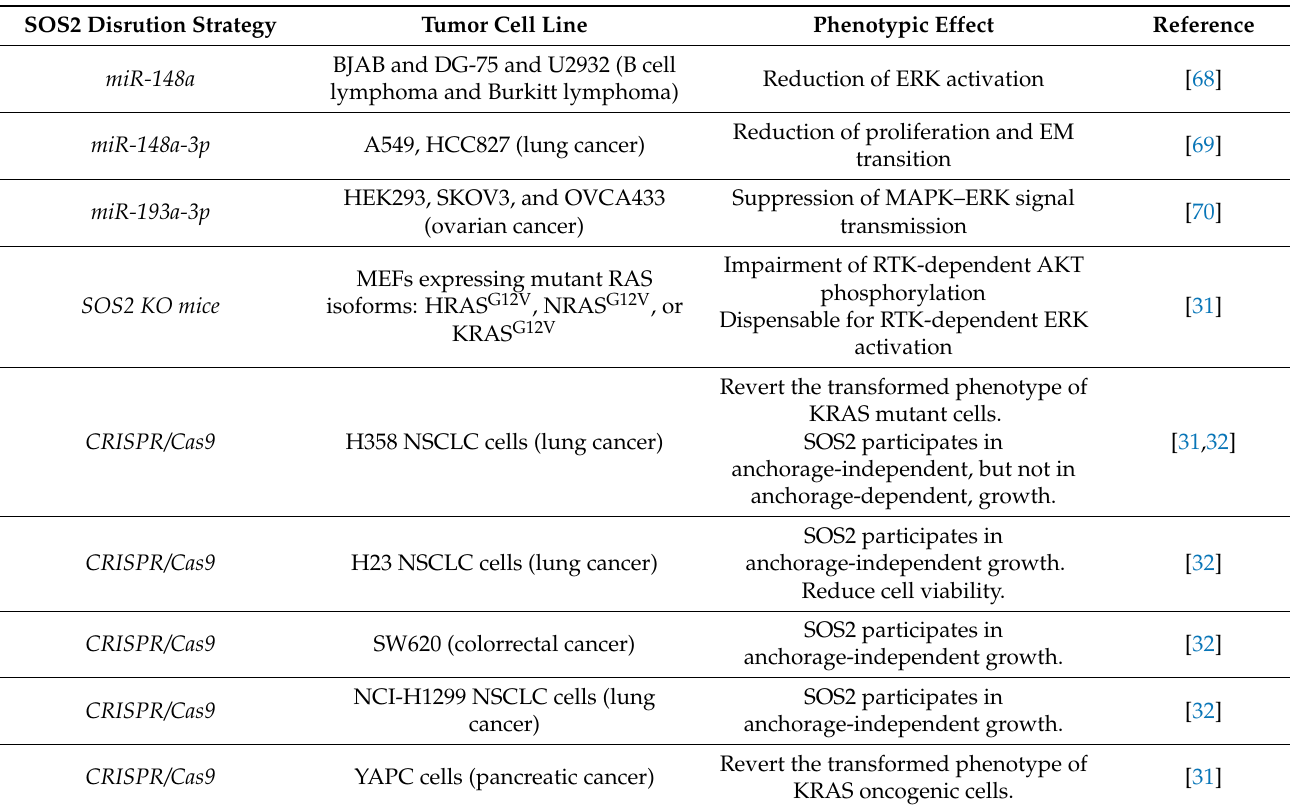
Table 2. SOS2 gene silencing strategies in different tumor cell types . List of genetically-based strategies to downregulate SOS2 gene in the indicated tumor cell lines. Resulting phenotypic consequences of SOS2 disruption are shown in the corresponding